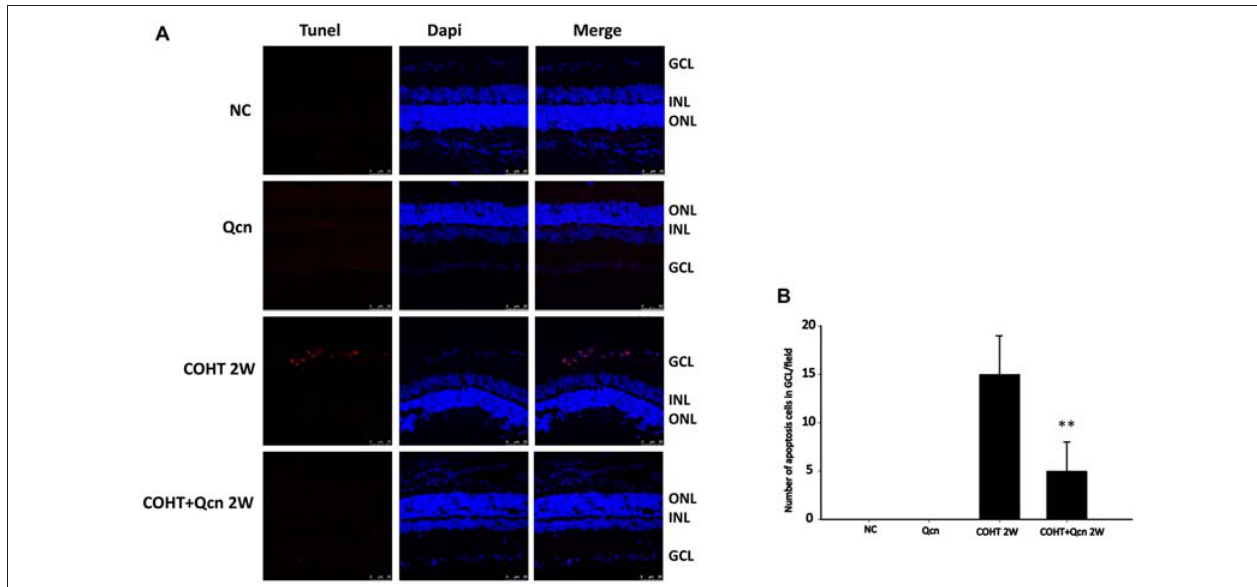
FIGURE 4 | (A) Terminal Deoxynucleotidyl Transferase dUTP Nick End-Labeling (TUNEL) analysis of retinas from four different treatment groups (NC, Qcn, COHT and COHT+Qcn groups) at 2 weeks after microbead injection. Red indicates TUNEL-positive cells, and blue indicates DAPI. GCL, retinal ganglion cell layer; INL, inner nuclear layer; and ONL, outer nuclear layer. Scale bar, 50 µ m. (B) Quantitative analysis of TUNEL-positive cells in retinas from different treatment groups. The data are presented as the mean ± SD. ∗∗ p < 0.01.